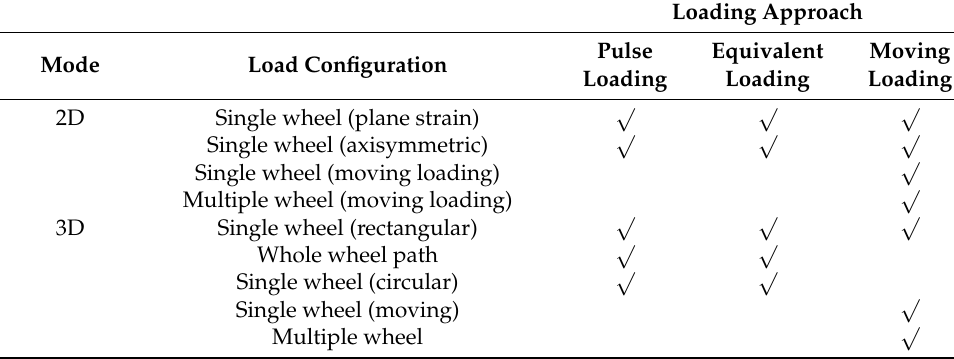
Table 4. The commonly used FEM simulation loading